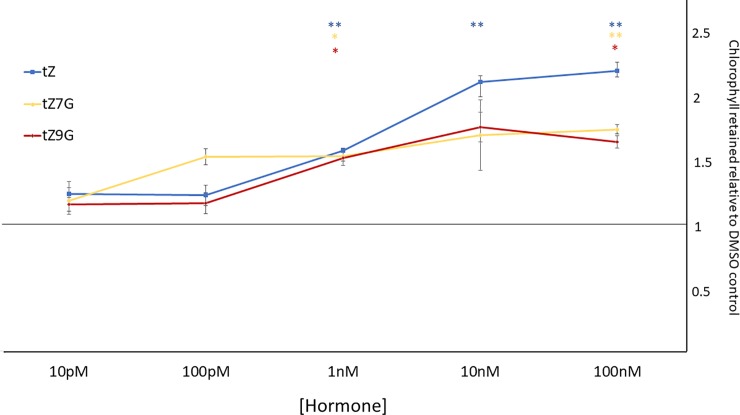
trans-Zeatin-N-glucosides delay chlorophyll degradation in detached cotyledons in a dose-dependent manner.Experiment performed identically to that in Fig 1 but with different concentrations of hormones. Average ± SE of three biological replicates is presented as a normalized level of chlorophyll relative to the chlorophyll content in the DMSO control cotyledons. Significance was determined by a two-way ANOVA (treatment factor, p-value = 0.0005) followed by post-hoc t-tests comparing hormone treatments to DMSO control. * p-value < 0.05, ** p-value < 0.01. Significance asterisk colors correspond to the line of the same color.